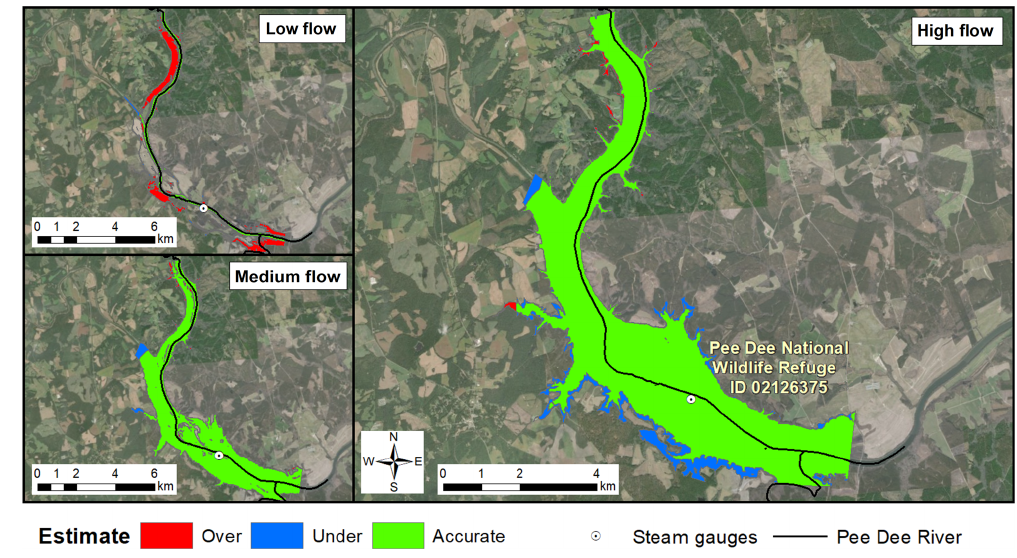
Figure 8. Pee Dee, NC (NC-3m), flood map comparison between AutoRoute + ARPP simulations using ∼ 3m DEM and USGS flood maps. Areas shaded green (Accurate) indicate areas where AutoRoute + ARPP and the USGS flood maps agree. Areas shaded red (Over) indicate where only AutoRoute + ARPP simulates the area as flooded. Areas shaded blue (Under) indicate where only the USGS shows the area as flooded. Sources of the background imagery include ESRI, DigitalGlobe, Earthstar Geographics, CNES/Airbus DS, GeoEye, USDA FSA, USGS, Getmapping, Aerogrid, IGN, IGP, and the GIS user community.